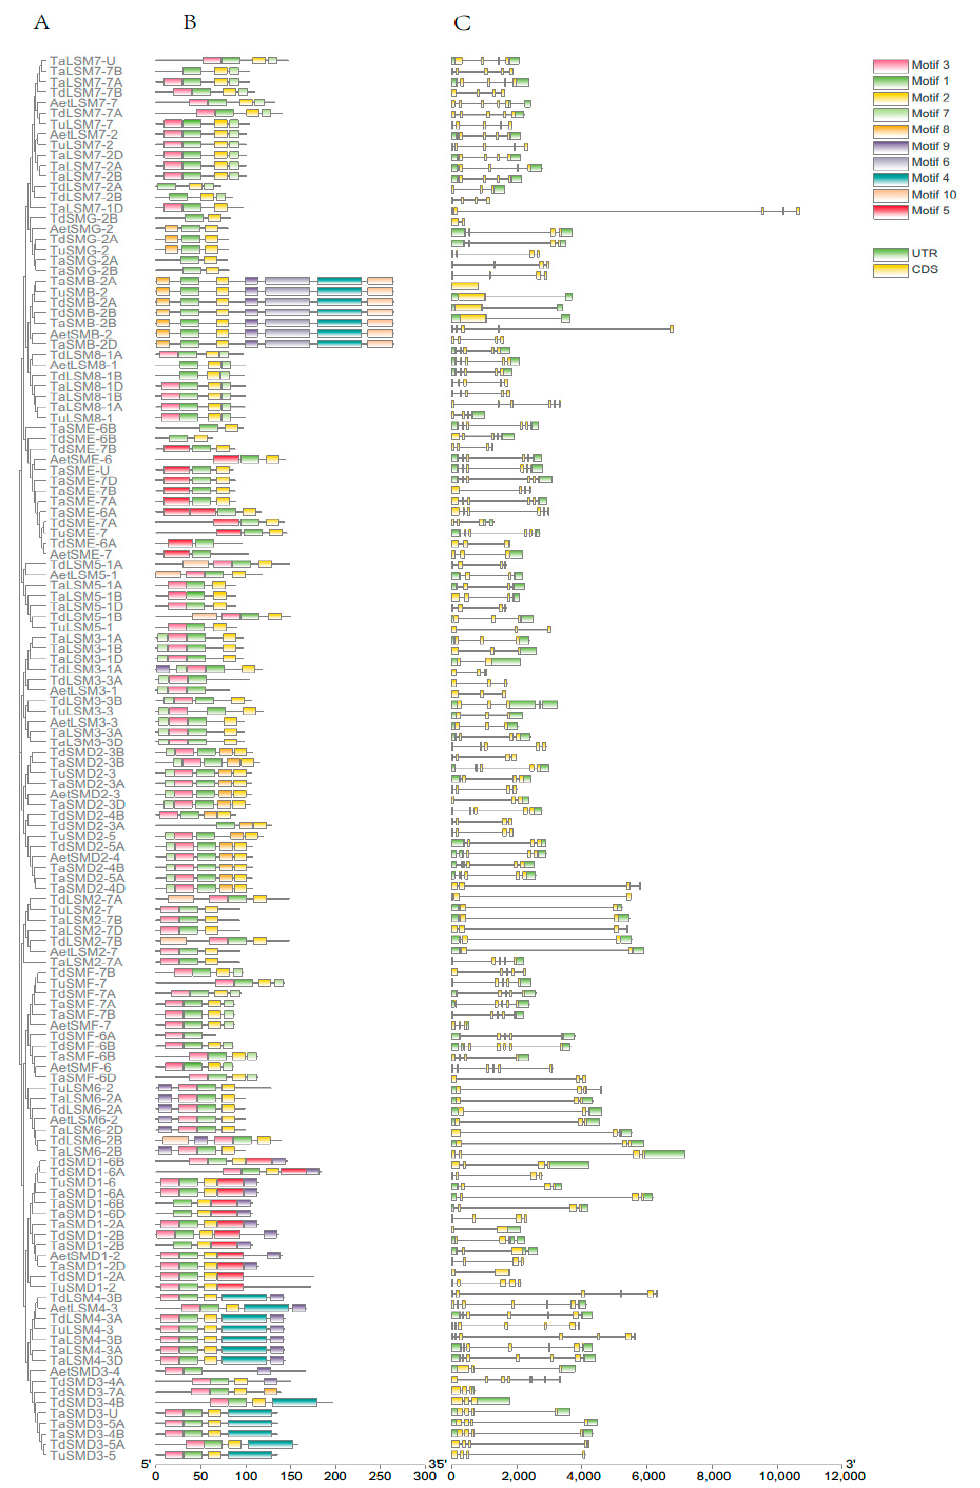
Figure 5. Phylogenetic relationships ( A ), motif compositions ( B ), gene structure ( C ). The maximum likelihood (ML) tree was constructed using MEGAX based on the full-length protein sequence. The exon–intron structures of these genes were graphically displayed by the Gene Structure Display Server using the CDS and genome sequence of SSM/LSM genes. The protein sequences of SSM/LSM genes were used to predict the conserved motifs using the MEME Suite web server. In wheat, A. tauschii and T. urartu the LSM2 gene has three exons, it has four exons in T. dicoccoides . LSM3 gene in wheat and its ancestors has three exons except